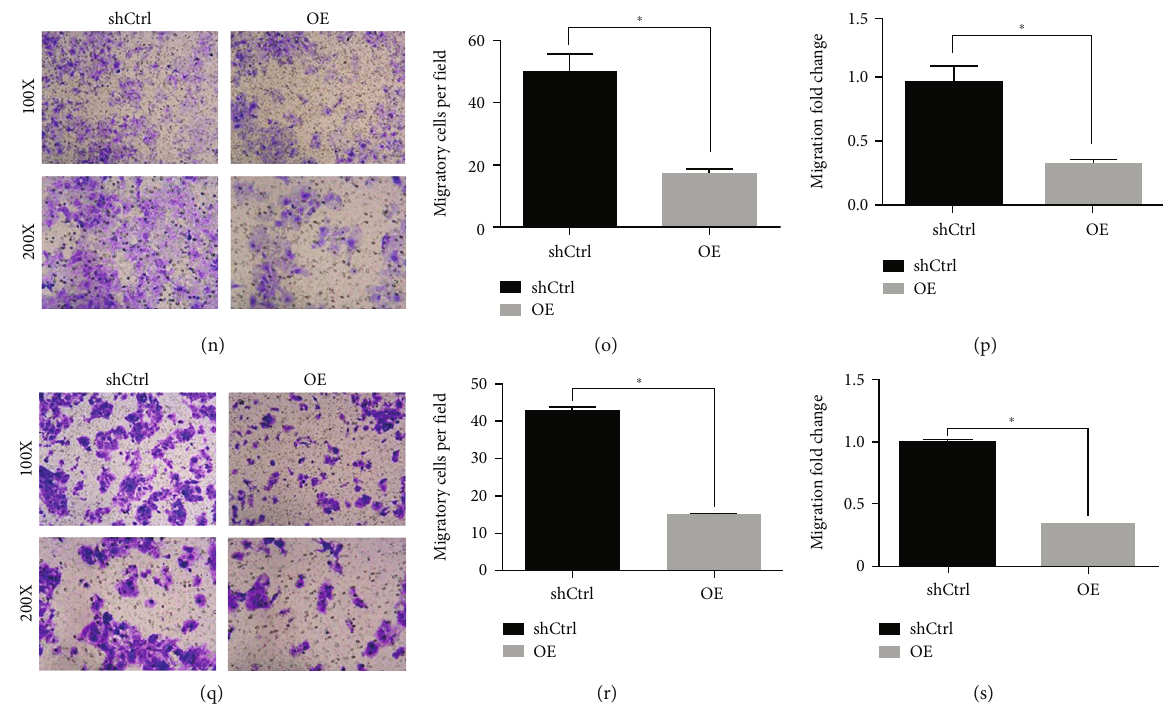
Figure 5: E ff ect of SCARA5 overexpression on the proliferation and migration of Hep 3B and Huh-7. (a – c) Expression of SCARA5 at mRNA level in Hep 3B and Huh-7 cells was detected by qRT-PCR before and after transfection of siRNA. (d and g) Expression of SCARA5 at protein level in Hep 3B and Huh-7 cells from the OE and the control group was detected by western blot assay. (e, f, h, and i) E ff ect of SCARA5 overexpression on the proliferation of Hep 3B and Huh-7 cells was evaluated using clone formation assay. (j – m) E ff ect of SCARA5 overexpression on the apoptosis of Hep 3B and Huh-7 cells was evaluated by FCM. (n – s) E ff ect of SCARA5 overexpression on the migration of Hep 3B and Huh-7 cells was evaluated by Transwell cell migration assay. ∗ P < 0 : 05